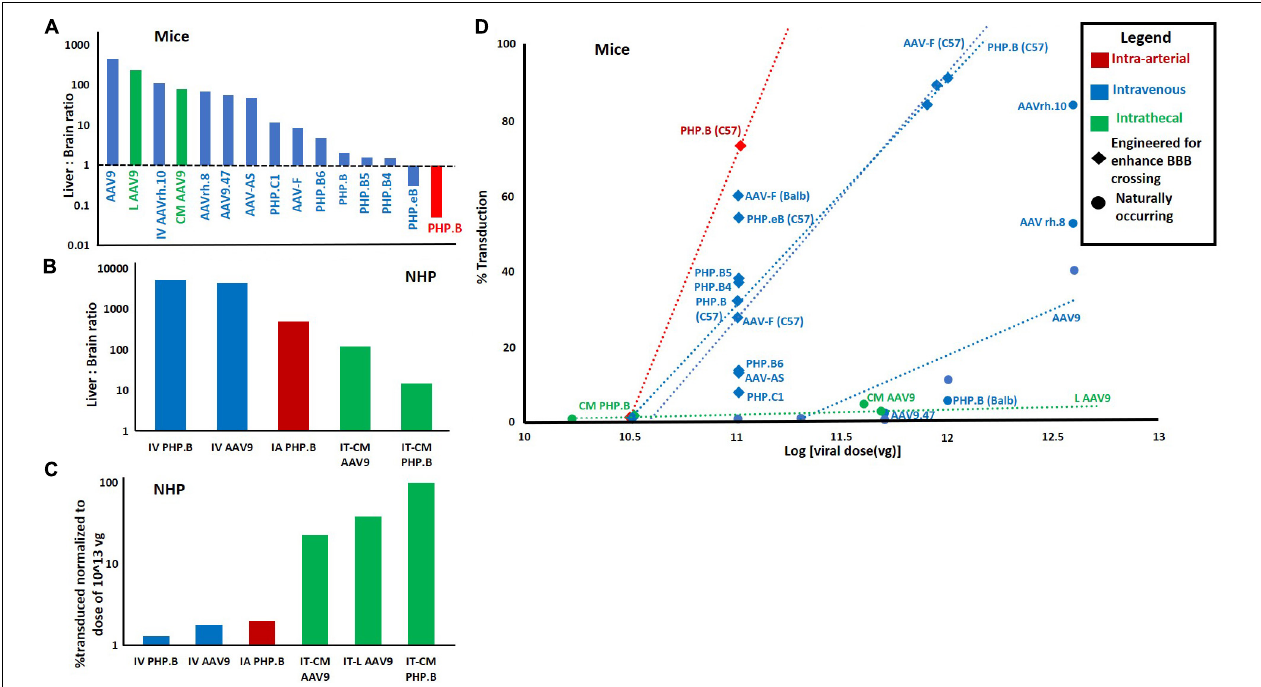
FIGURE 2 | Meta-analysis of 14 papers reporting quantitative metrics of transduction efficiency using different routes and AAV serotypes. (A) Liver: brain ratio by route and serotype in mice. 26 data points from 12 studies in mice. Each used qPCR to report viral genome concentration in both liver and brain. Viral concentration in liver was divided by viral concentration in brain after injection of a single dose via IV, IT, or lA routes. (B) Liver: brain ratio in non-human primates. Eight data points from four studies in non-human primates. Calculated using same method as “A.” For bath panels (A,B) the greater the ratio, the less efficient the route/serotype. combination . (C) Percent transduction in NHPs normalized to a median dose of 10 13 . Percent transduction was calculated either by% GFP positive cells reported by authors or by estimating the percentage of brain cells transduced multiplying the number of viral genomes per cell calculated by authors via qPCR by 100 (i.e., if the ratio of viral genomes to normal cells is 1 then it was estimated that all cells or 100% of cells were transduced). This was then normalized to the median dose of l × l0 13 vg by dividing the % transduction by the ratio of actual dose/median dose. Data was extrapolated from 10 data points from 4 studies in non-human primates. (D) % transduction (calculated by the same method as in panel C ) vs. viral dose for different combinations of routes and serotypes. In the event that there the same route/serotype was used at different concentrations, the linear regression of these values is displayed as a dotted line with this line labeled, rather than each data point. This data was extrapolated from 31 data points from 11 studies was used. In panels (A–D) if there were multiple data points for a given route/serotype combination (and in panel (D) route/serotype/dose combination) the average of all data points was